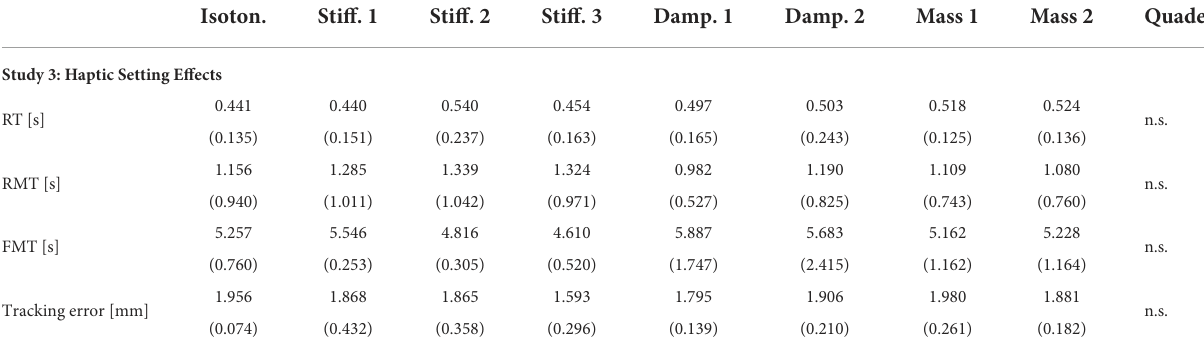
TABLE 7 Effects of haptic settings on performance measures: Means, SD (in parentheses), and Quade main effects.